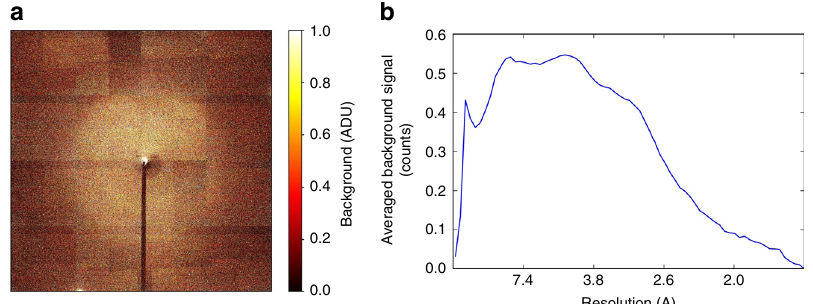
Fig. 2 Quantitative analysis of the scattering background. Background scattering level from phycocyanin crystals mounted on a silicon chip (excluding diffraction intensities from Bragg peaks) highlighting the extremely low background level achievable with 3 × 10 10 photons/pulse ( a ). Radially averaged background level for the diffraction image as function of resolution ( b APS. Examples of the resulting Laue diffraction patterns from the extremely low background levels achieved in our experiment. proteinase K and phycocyanin crystals are shown in Fig. 1. The diffraction spots appear well separated and only slightly elliptical as seen in the insets and radial line pro fi les. The spots only have a small elongation in the radial direction, which implies a small degree of crystal mosaicity 39 . A large degree of crystal mosaicity, resulting in spots that are radially streaked, often leads to dif fi culties in data processing and is stated as a major limitation of Laue crystallography 40,41 . The diffraction patterns further reveal